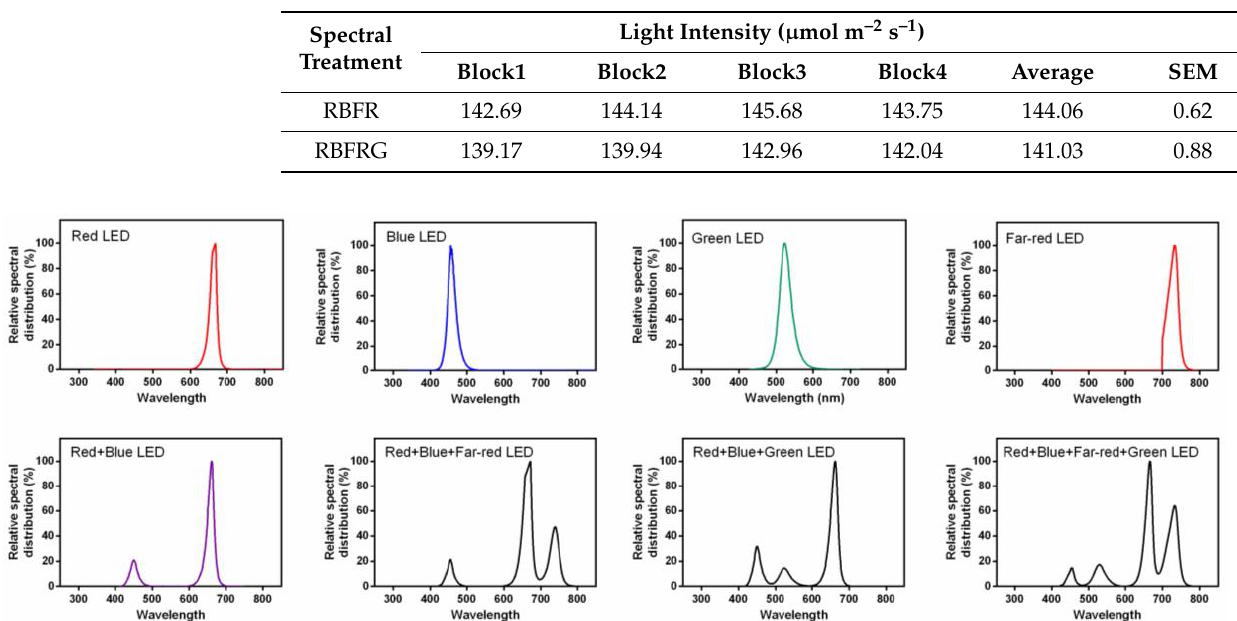
Figure A3. Effect of partial (20%) substitution of red/blue (RB; 3:1) with green (G) light in the pres- ence or absence of far-red light (FR) on the leaf number of tomato plants 21 days after treatment. Four genotypes were studied: ( A ) WT (Moneymaker; wild-type), ( B ) phyA (phytochrome A-defi- cient), ( C ) phyB1B2 (phytochrome B1- and B2-deficient), and ( D ) phyAB1B2 (phytochrome A-, B1-, and B2-deficient). Light treatment and genotype did not significantly interact ( p = 0.629). Data pre- sented are averages, with the SE based on 5 blocks ( n = 5), each containing 3 replicate plants (Exp1).